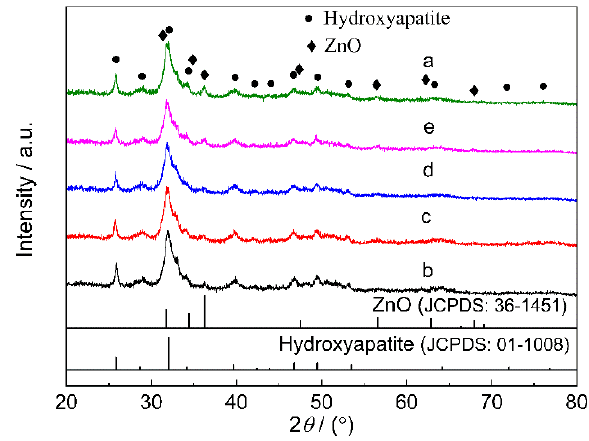
Figure 1. XRD patterns of ZnO/BC samples.